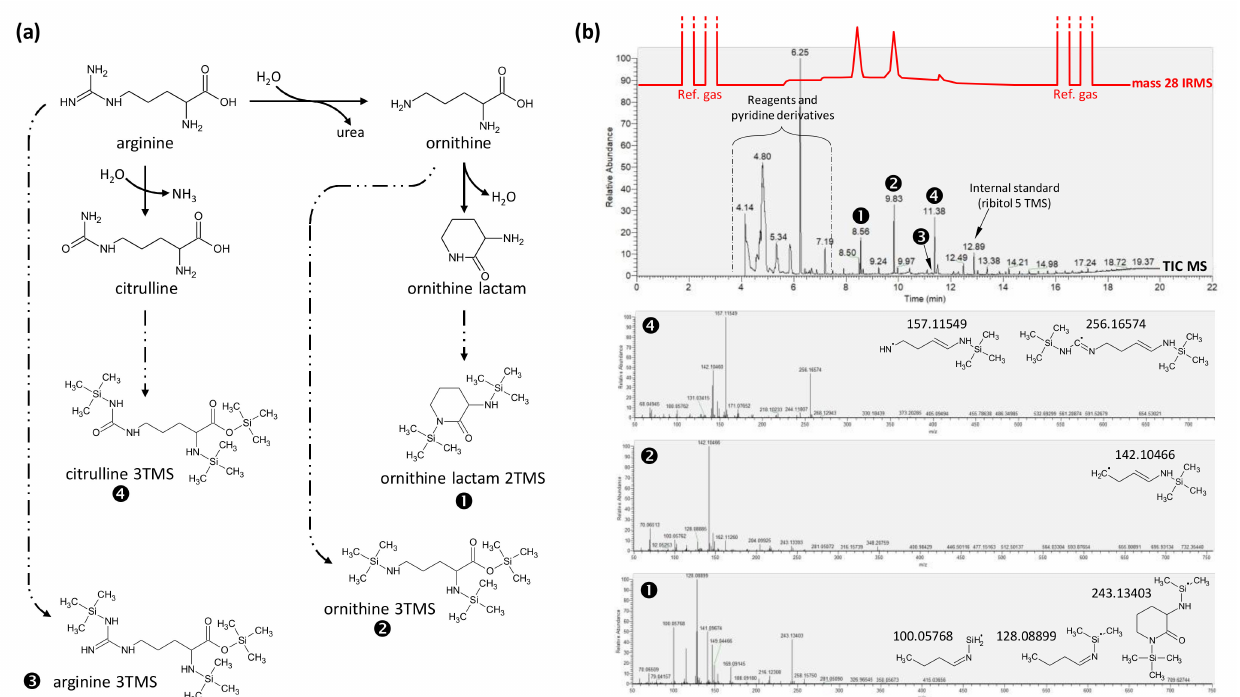
Figure 4. Major products of arginine derivatization (silylation) under our conditions . ( a ) Chemical pathway showing the four main products formed from arginine. ( b ) TIC trace of the GC-MS and associated MS spectra showing the three major peaks obtained: ornithine lactam 2TMS, ornithine 3TMS and citrulline 3TMS. Arginine 3TMS (peak no. 3) is of negligible importance (in contrast to derivatization carried out with methoxyamine, Figure S1). Major fragments and associated exact mass are shown on bottom panels. The IRMS trace (mass-28) is superimposed on top to show the modest contribution of citrulline (peak no. 4) in absolute terms (moles of N) compared to ornithine (peaks no. 1 and 2). To facilitate reading, a magnified version of this figure is provided in Supplementary